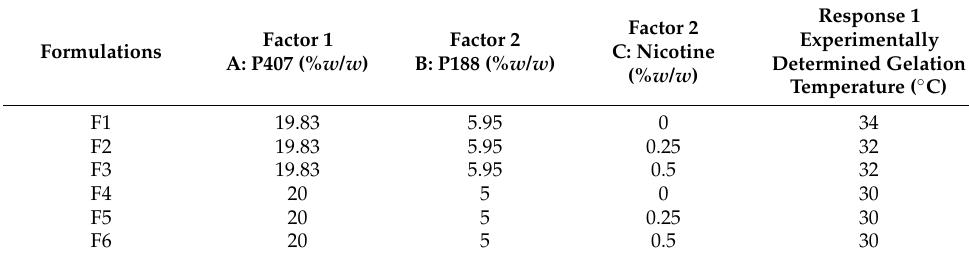
Table 6. Gelation temperatures for the optimized formulation.